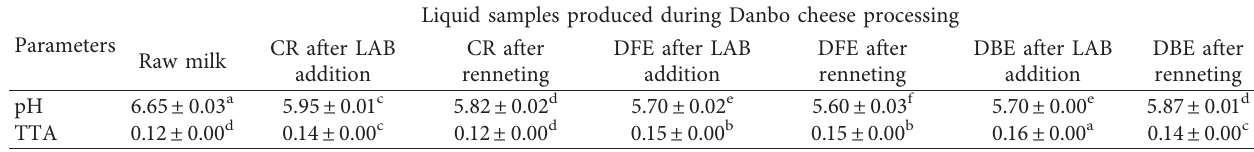
Table 6: pH and TTA of raw milk and liquid samples during Danbo cheese processing.